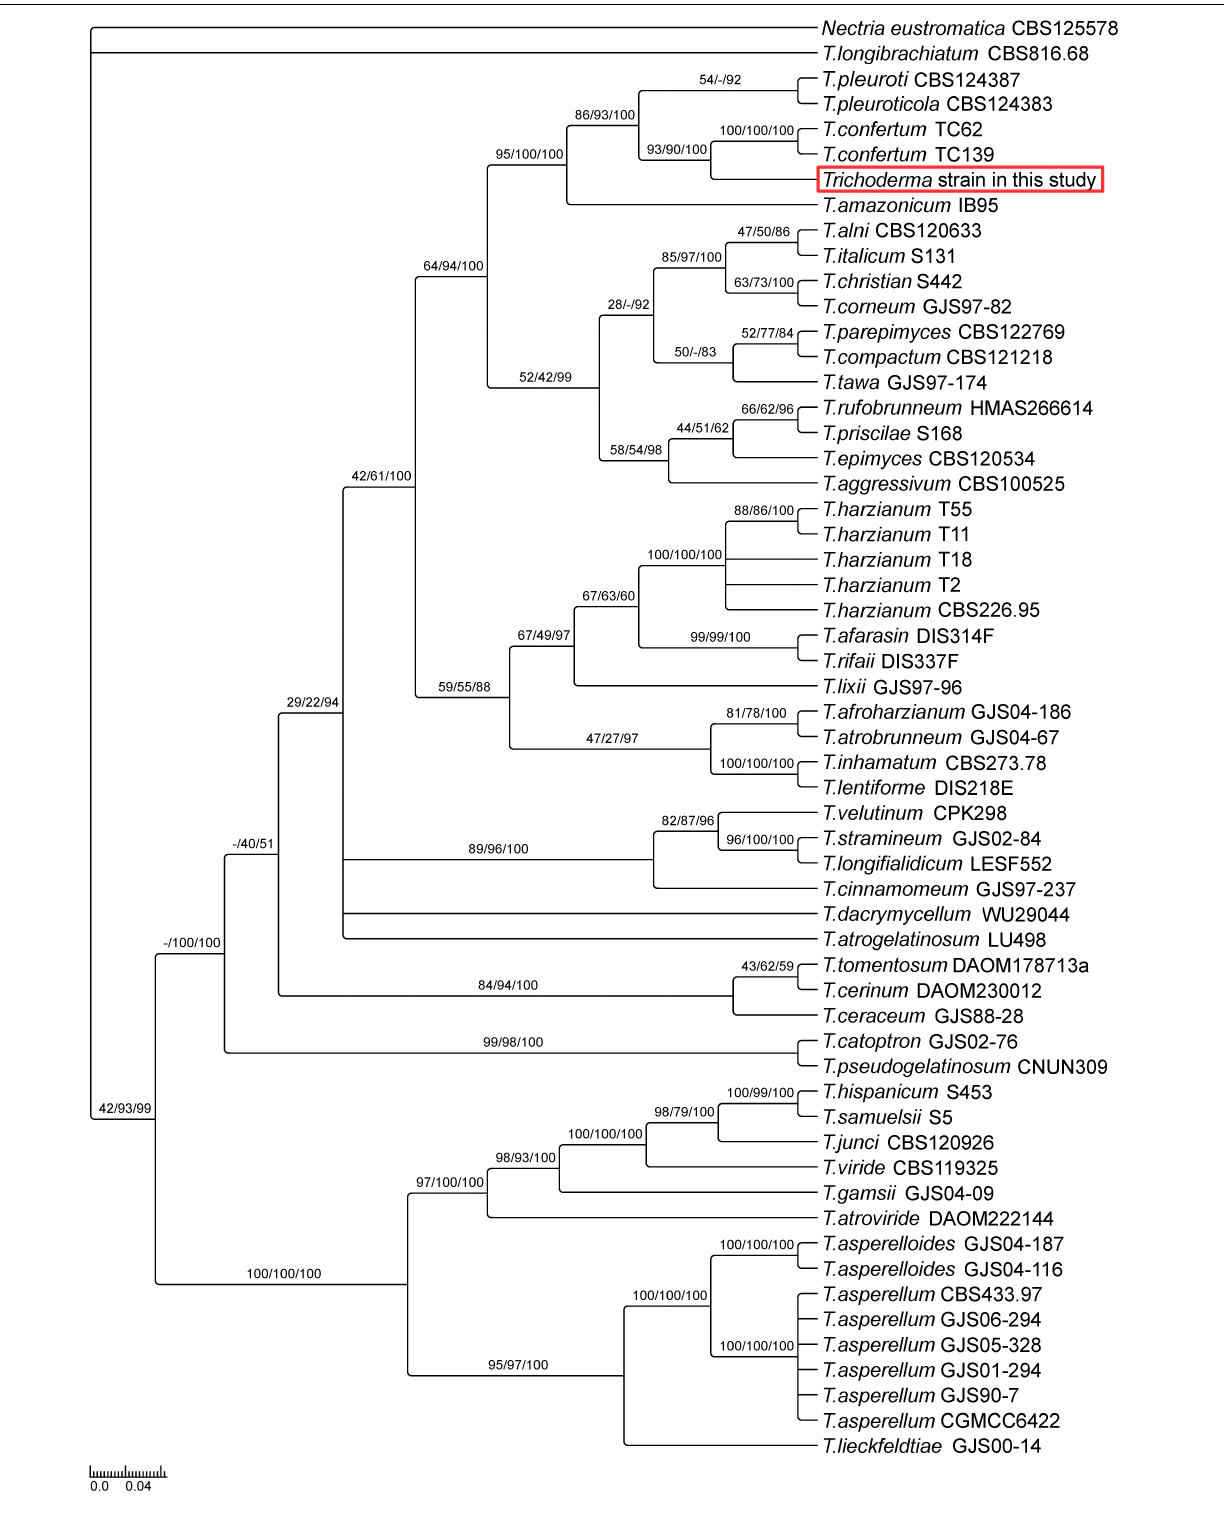
Frontiers in Plant Science |